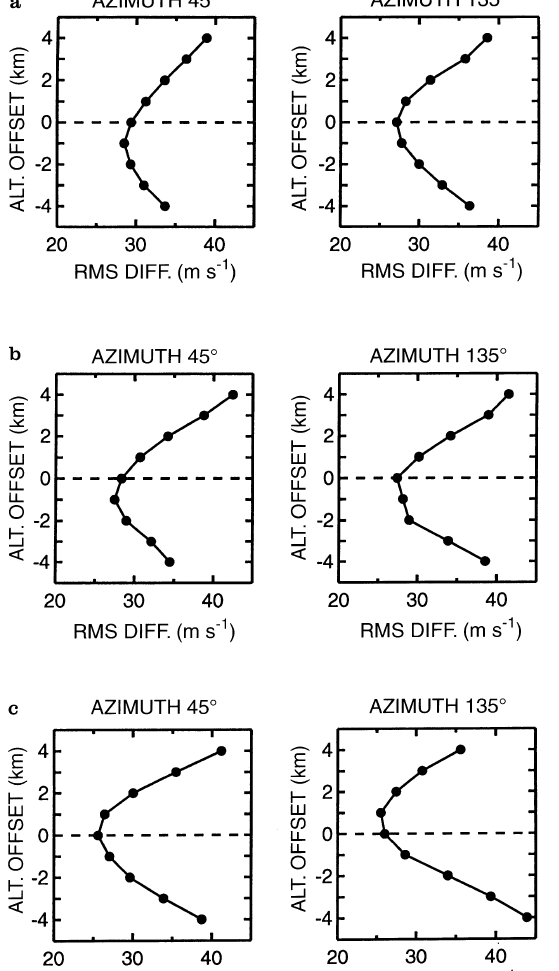
Fig. 12a–c. RMS di(cid:128)erences as a function of the altitude o(cid:128)set of the WINDII data set relative to HRDI, for the 45 (cid:176) azimuth ( left-hand panels ) and the 135 (cid:176) azimuth ( right-hand panels ) a on 24 January 1993, b on 3 January 1993, and c on 29 April 1993